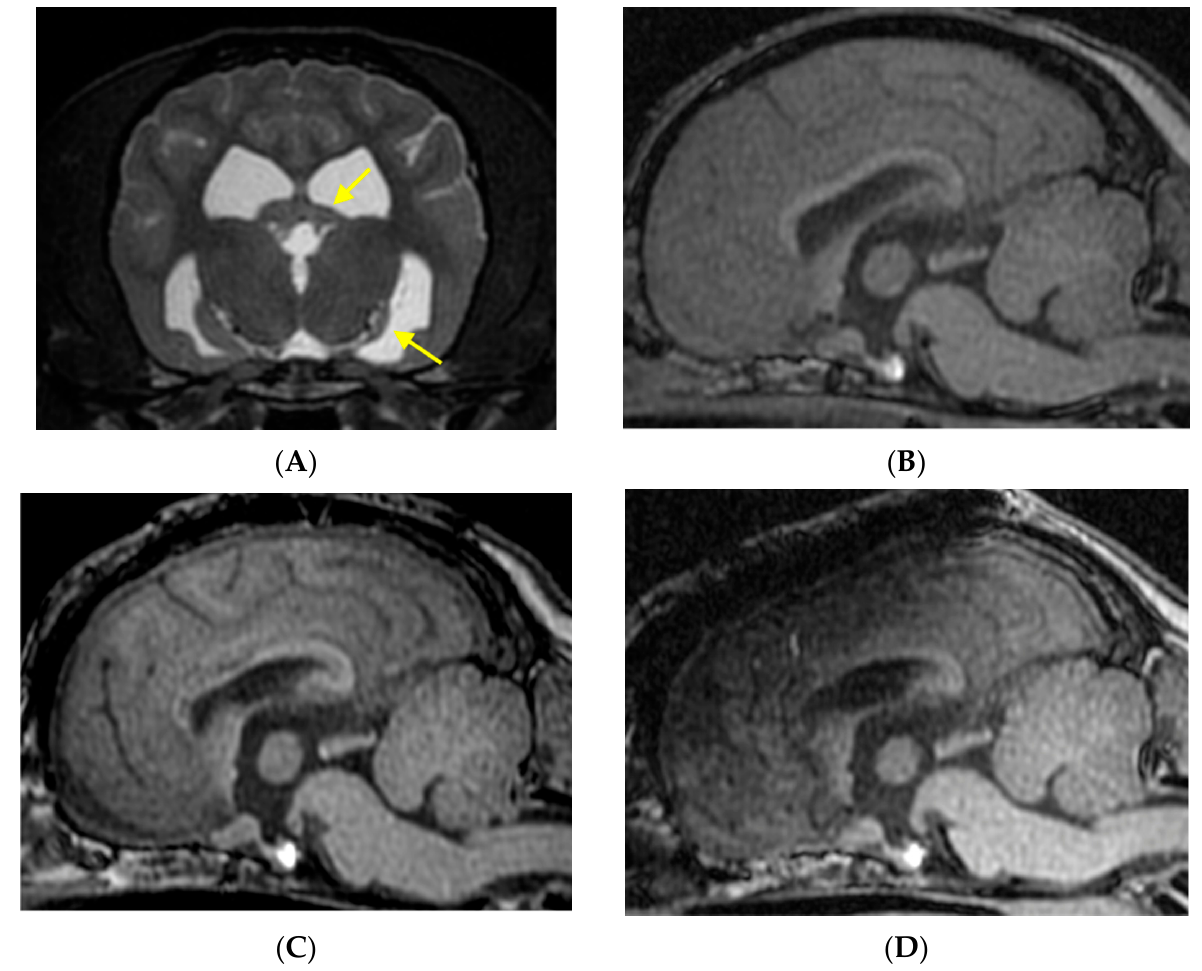
Figure 2. MRIs of preoperative ( A , B ), 9 months after the 1st surgery ( C ), and 12 months after the 2nd surgery ( D ) in Case 1. Marked atrophy of the left hippocampus is observed (( A ) T2-weighted transverse). Predisposed Chiari-like malformation is observed (( B – D ), T1-weighted midline sagittal). Anterior 1/2 CC was performed at the 1st surgery ( C ). An additional caudal extension of the CC (anterior 2/3) and cortical resection of anterior part of the left cingulate gyrus were conducted at the 2nd surgery (( D ); because of titanium plate on the skull, the signal intensity of the dorsal part of the head is